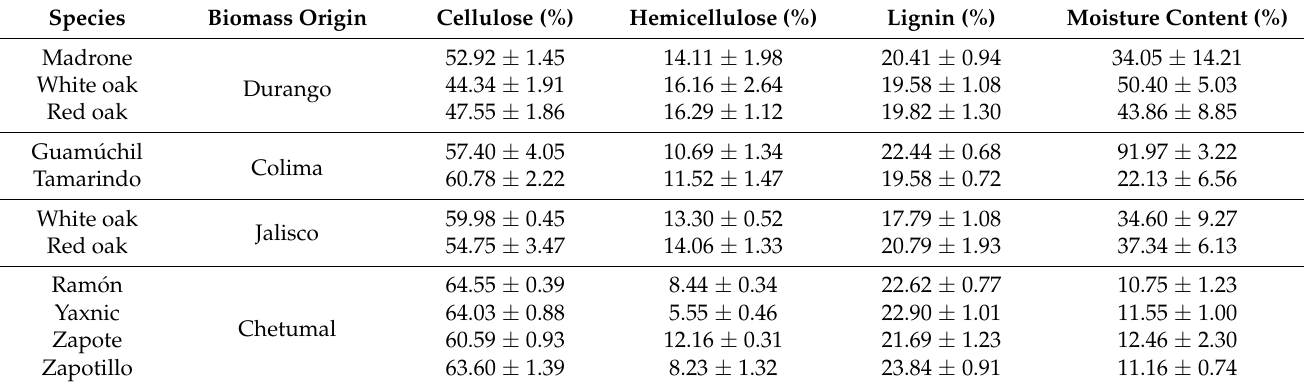
Table 2. Chemical composition, density and moisture content of the biomass used for conversion to charcoal.